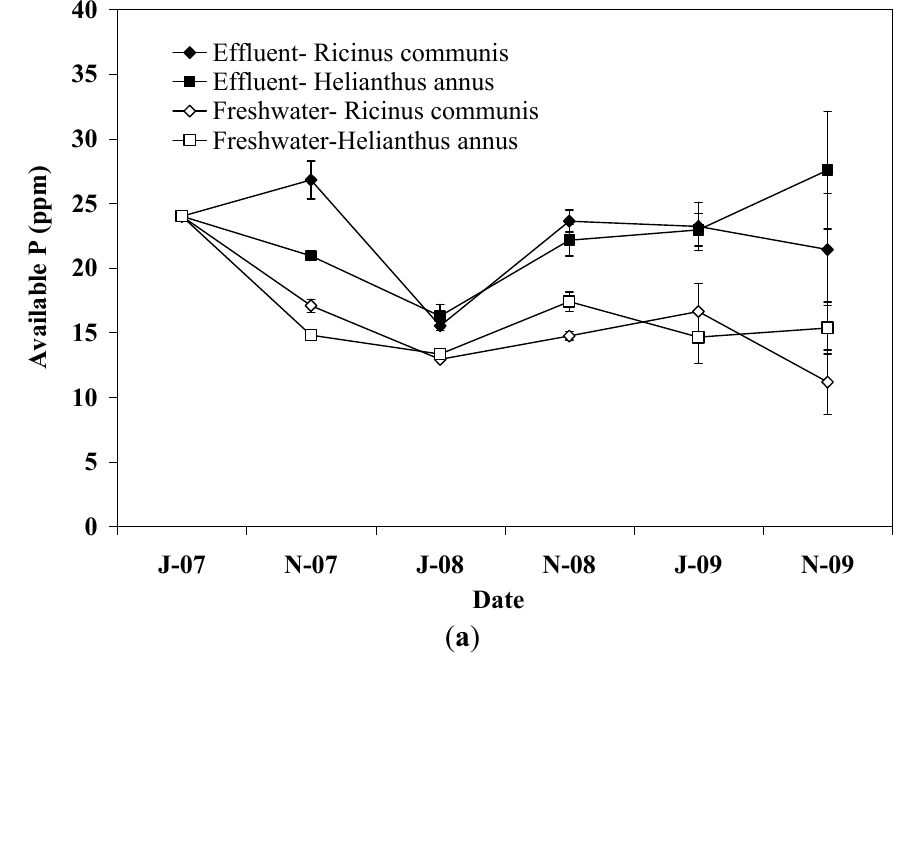
Figure 3. Average values of soil available P as a function of ( a ) water quality and plant species; and ( b ) water quality and soil depth, during the three irrigation periods